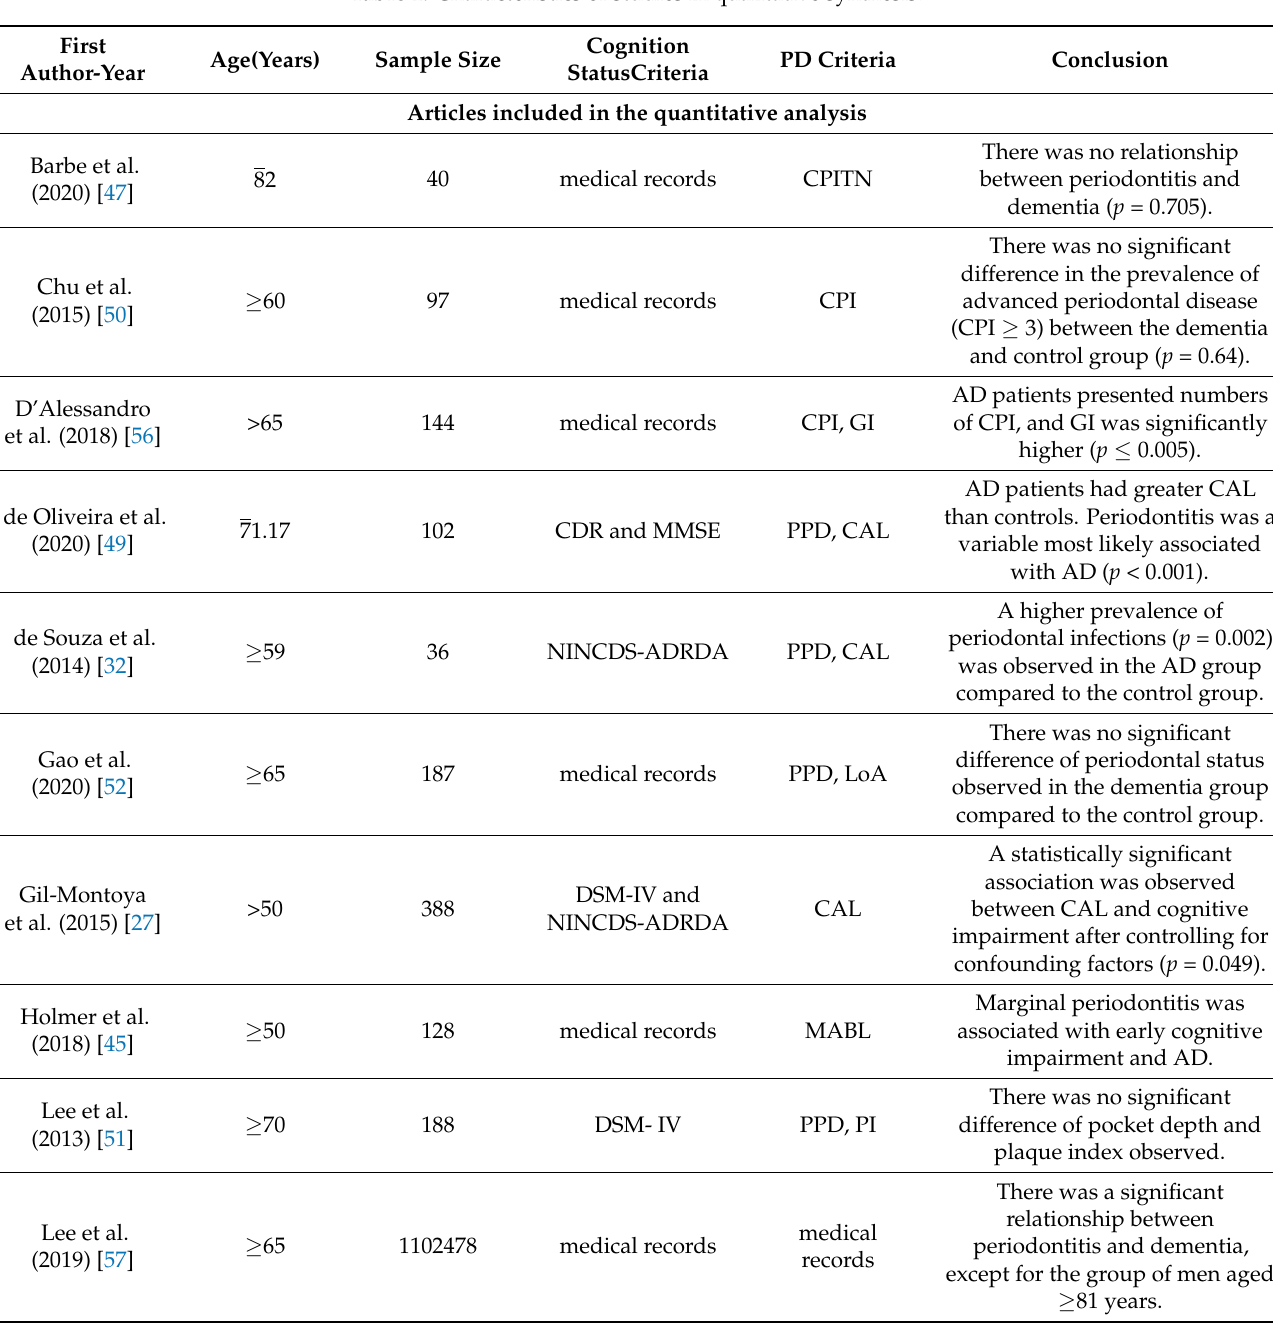
Table 1. Characteristics of studies in qualitative